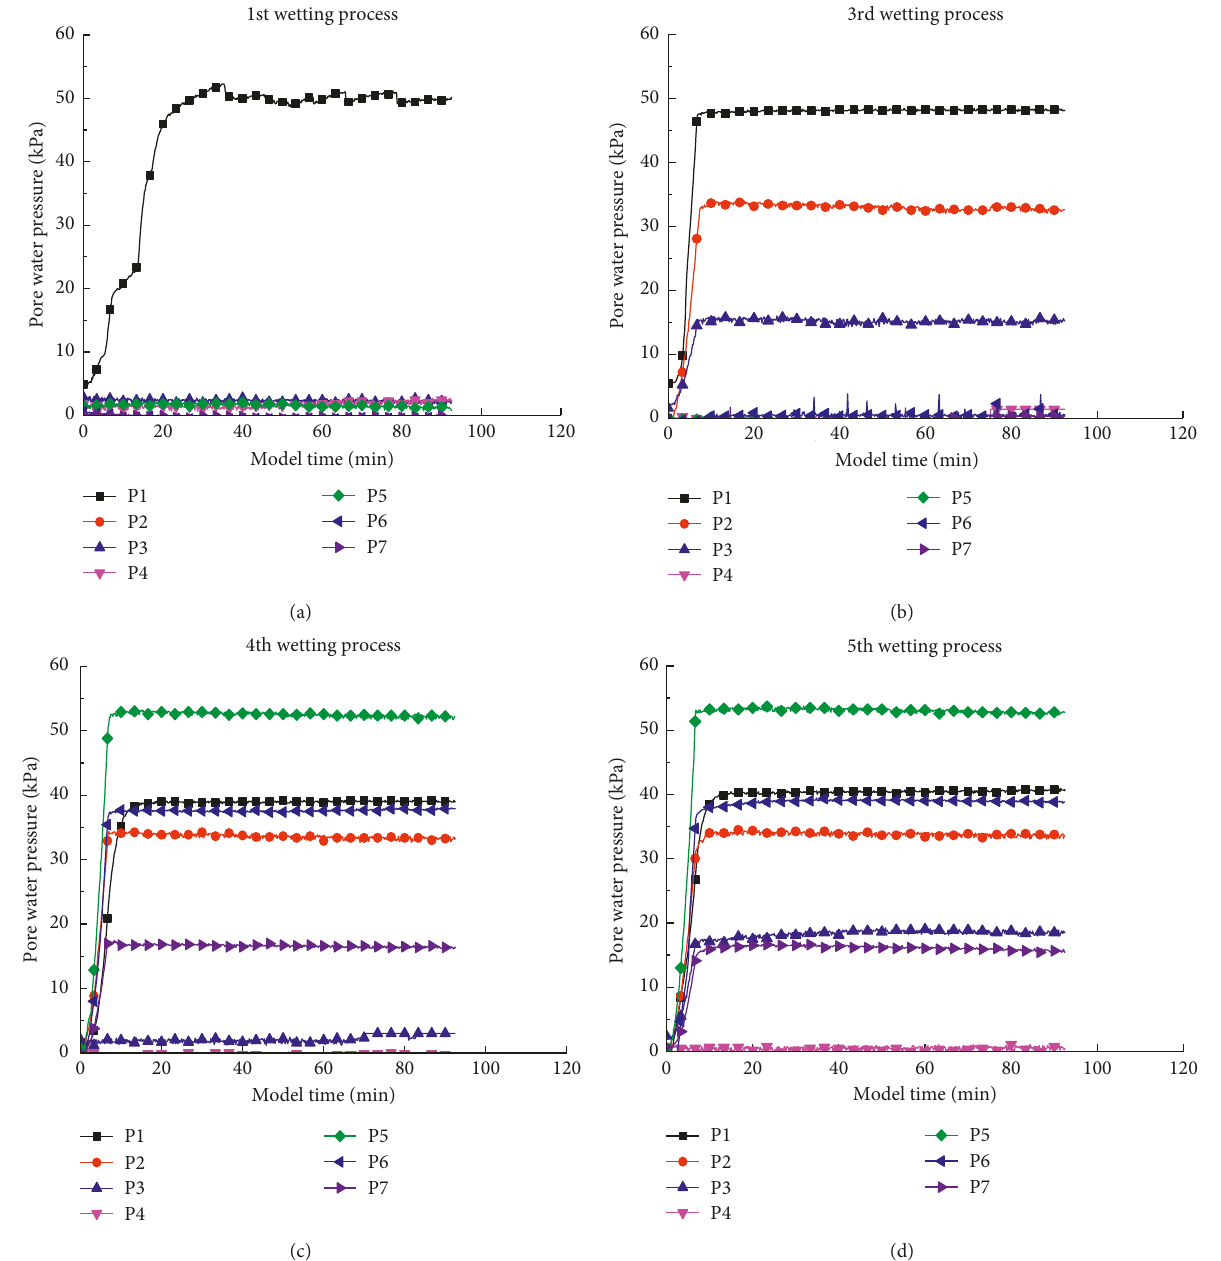
Figure 9: Variation of pore water pressure with model